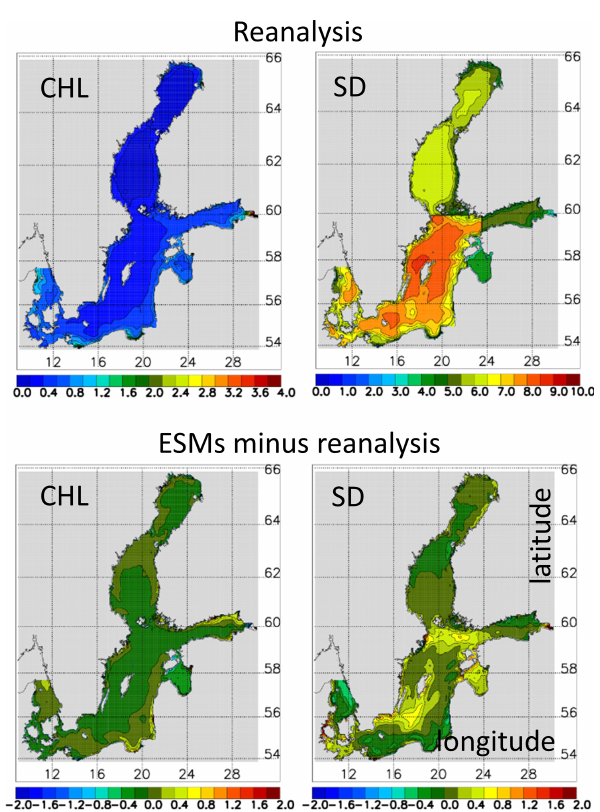
Figure 10. Upper panels: annual mean phytoplankton concentra- tions (CHL; in mgChlm − 3 ) and annual mean Secchi depth (SD; in m) of the reanalysis data for 1976–1999 (Liu et al., 2017). Phyto- plankton concentrations are vertically averaged for the upper 10m. Since in the calculation of the Secchi depth as background only one value for the concentration of yellow substances per sub-basin is available, artificial borders between sub-basins become visible. Lower panels: difference between the climatologies of the ensemble mean of the ESMs (Saraiva et al., 2019a) and those of the reanalysis data for the historical period